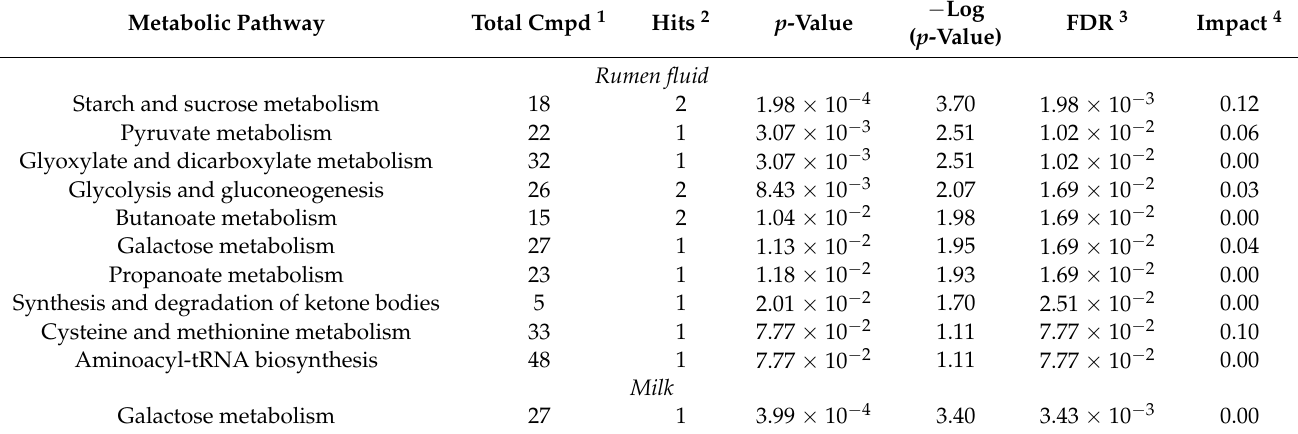
Table 4. Pathway analysis of significantly different rumen fluid and milk metabolites compared with healthy and subclinical ketosis